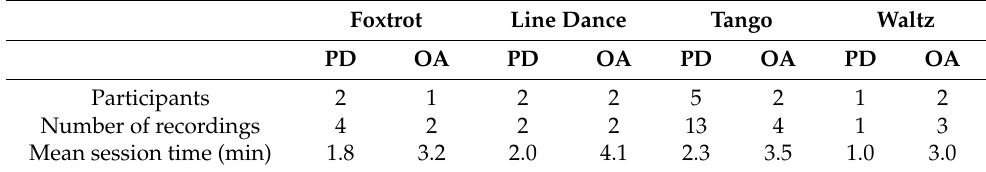
Table 1. Number of participants, recordings, and the mean length of recordings for each dance. Foxtrot Line Dance Tango Waltz PD OA PD OA PD OA PD OA Participants 2 1 2 2 5 2 1 2 Number of recordings 4 2 2 2 13 4 1 3 Mean session time (min) 1.8 3.2 2.0 4.1